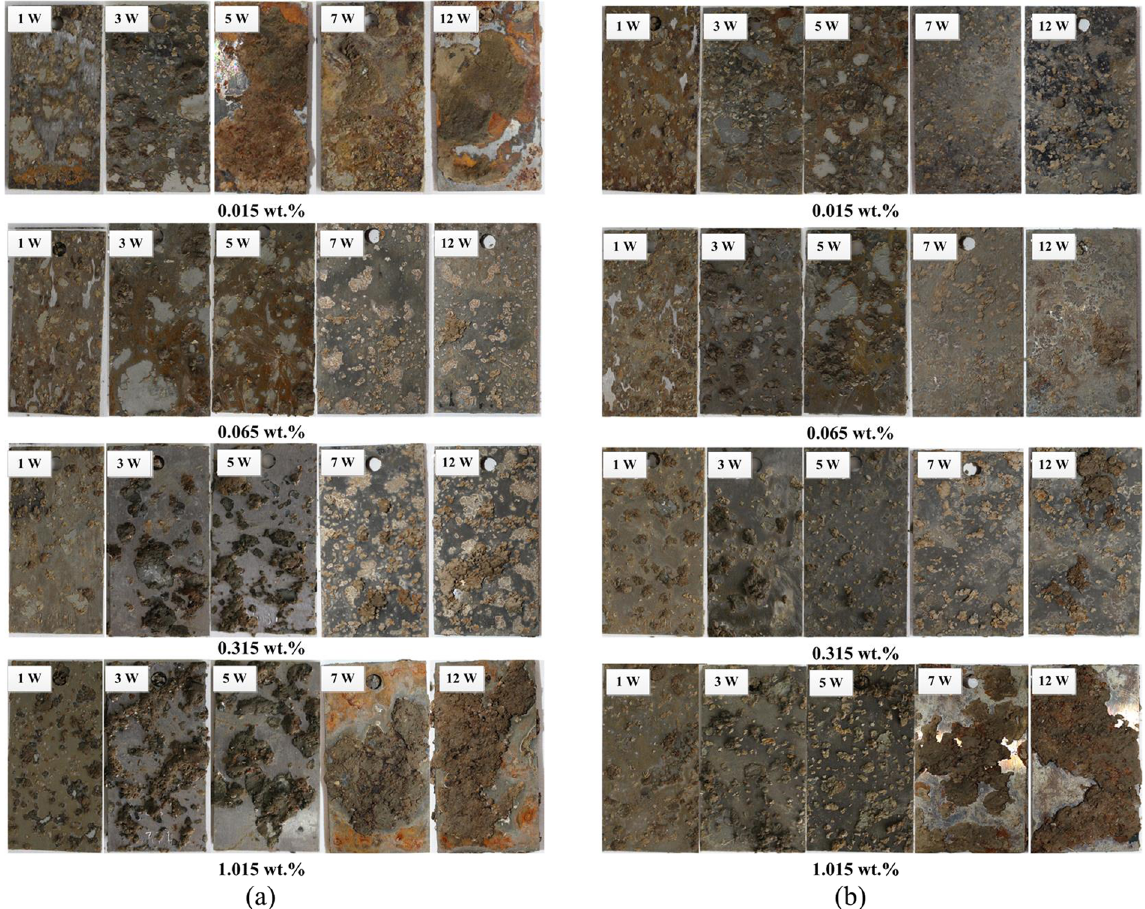
Figure 2. Ductile iron ( a ) and carbon steel ( b ) coupons exposed to soils of different chloride concentrations, i.e. 0.015%, 0.065%, 0.315%, 1.015% (wt.%) after 1, 3, 5, 7, 12